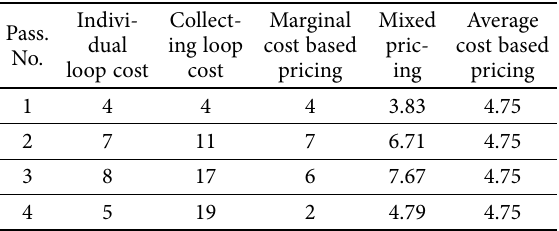
Table 6. Cost table for the pricing systems in case No. 2 Pass. No.